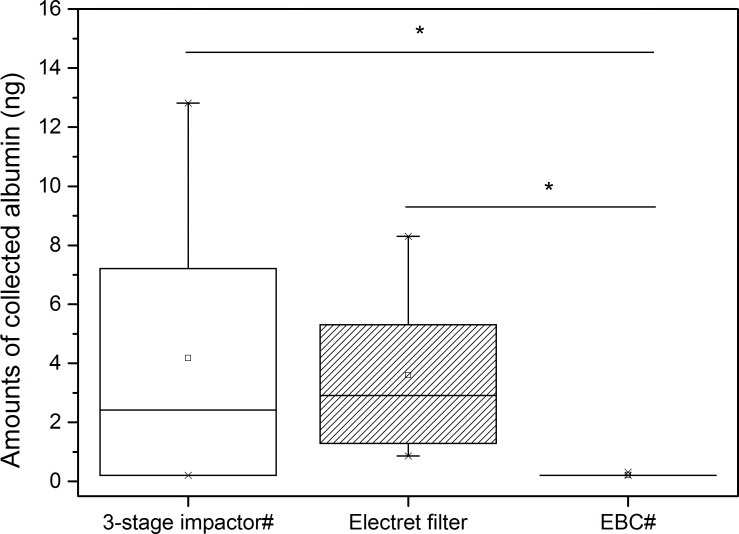
Comparison of collecting ability of 3 different collecting methods.*indicates significance at p<0.05. # indicates boxplot was drawn by the author from data in [22].